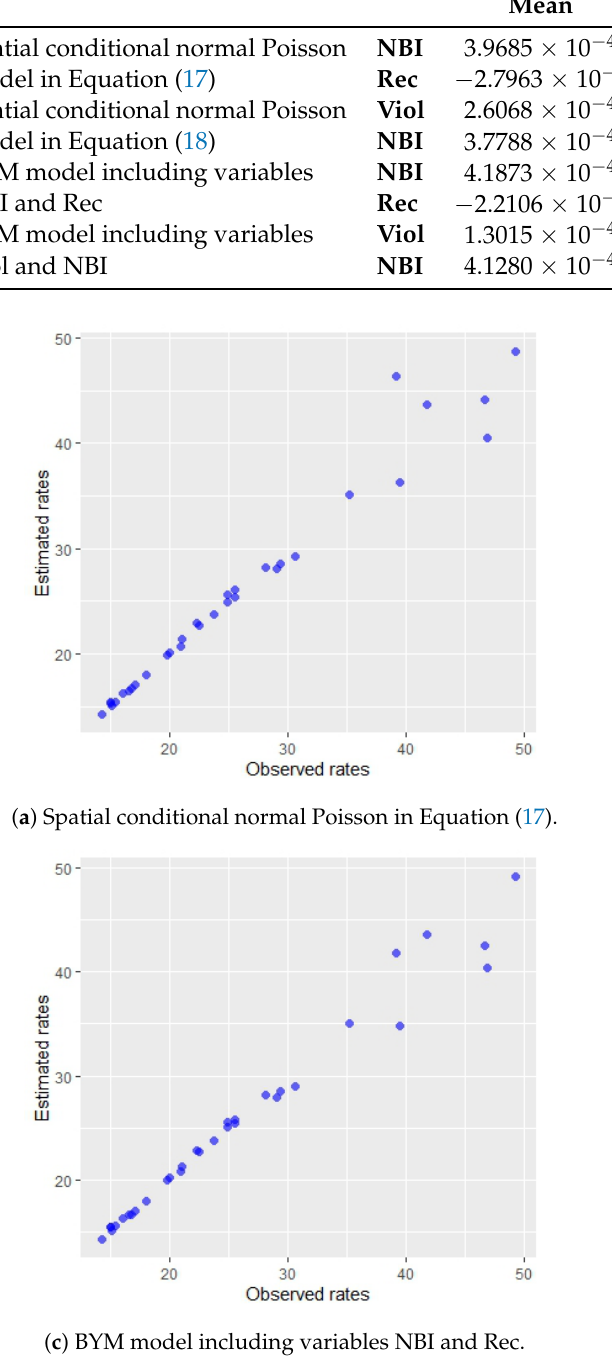
Figure 7. Scatterplots for the observed versus the predicted rates obtained by fitting the spatial conditional normal Poisson and Besag–York–Mollié (BYM) models in INLA for some of their reduced